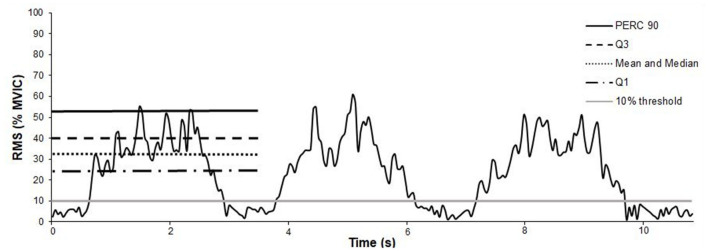
Representation of the 10% threshold (gray horizontal solid bar) applied to an exemplary set, with a root mean square (RMS) signal normalized by the maximum voluntary isometric contraction (MVIC). Besides, representation of the muscle activity parameters for an exemplary muscle contraction. sEMG amplitude parameters: 90th percentile (PERC 90), third quartile (Q3), mean and median, and first quartile (Q1).